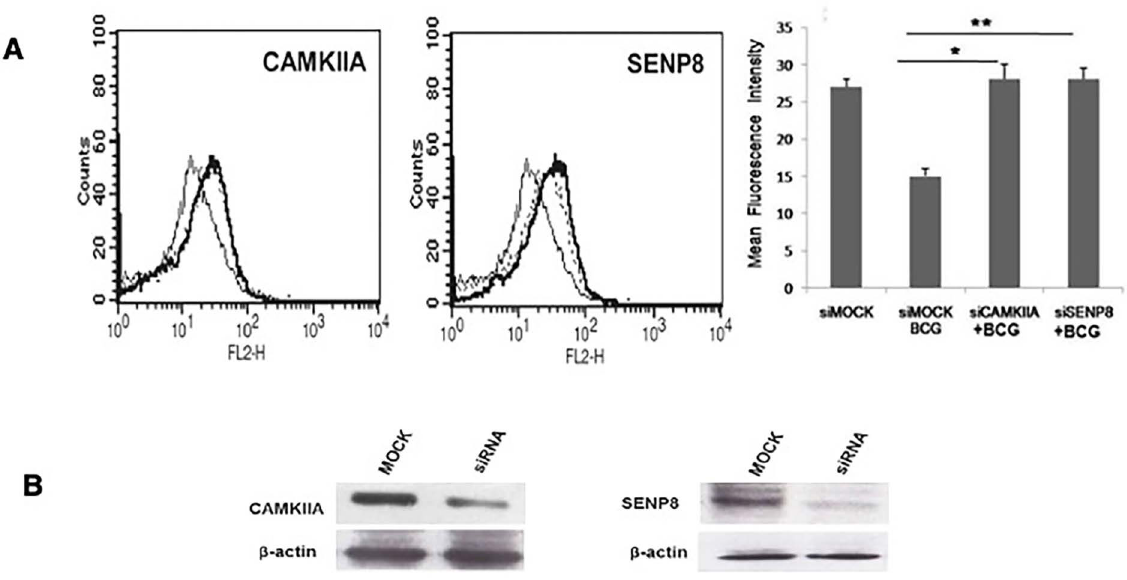
Figure 6: Calcium cysteine protease pathway genes regulate M. bovis BCG mediated IFN-γR expression on macrophages. (A) THP-1 derived macrophages were transfected with specific siRNAs against indicated molecules for 36h followed by infection with M. bovis BCG for 24h. IFN-γR levels were monitored by flow cytometry. In all the panels, dotted lines represent receptor levels in groups transfected with control siRNAs (MOCK), thin lines represent receptor levels in M. bovis BCG infected groups transfected with control siRNAs and bold black lines represent receptor levels in M. bovis BCG infected groups transfected with specific siRNAs against indicated molecules. *p<0.05 and **p<0.01, using one-way ANOVA with Tukey’s correction to calculate statistical significance between different groups. Data are represented as mean fluorescence intensities and expressed as mean ± S.D. (n=3). (B) Western blots to depict the knockdown efficiency of the siRNA treatment for the indicated